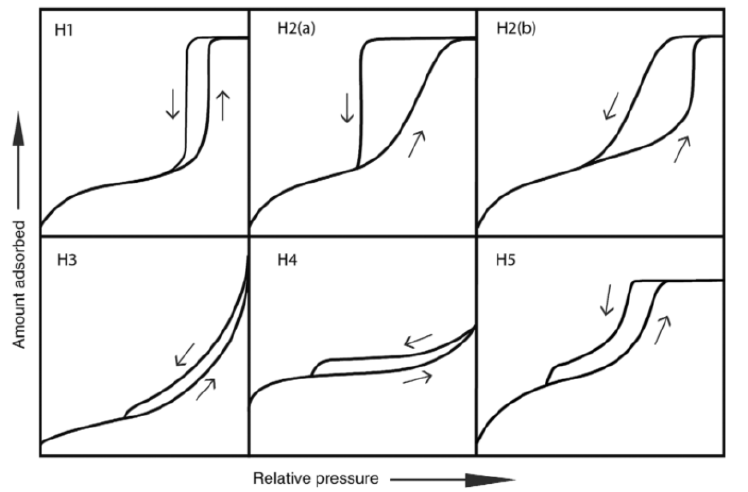
Figure 4. Classification of hysteresis loops [36]. Note: the quantity of gas adsorbed may be measured in any convenient units: moles, grams, and cubic centimeters et al were all used.